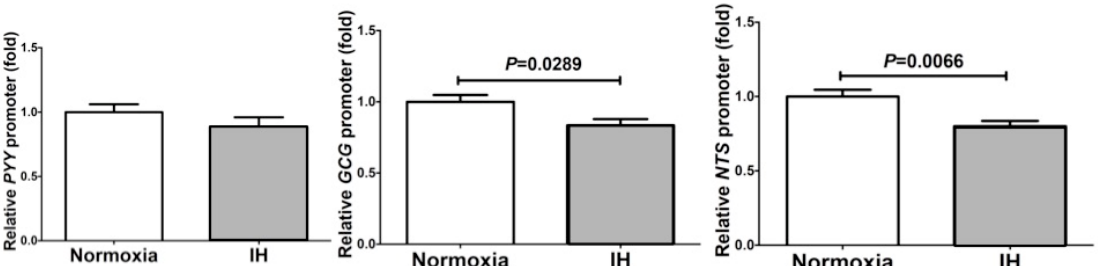
Figure 3. Promoter assays for PYY , GCG and NTS . The promoter activities of PYY , GCG, and NTS were not up-regulated by IH in Caco-2 cells. Caco-2 cells were transfected with constructs containing the PYY promoter ( − 2694 to +72), the GCG promoter ( − 1100 to +125), and the NTS promoter ( − 2938 to +209) upstream of a firefly luciferase reporter gene in the pGL4.17 vector. After the treatment with normoxia or IH, the luciferase activity was measured. All data are expressed as the mean±SE for each group ( n = 6). The statistical analyses were performed using Student’s t -test.